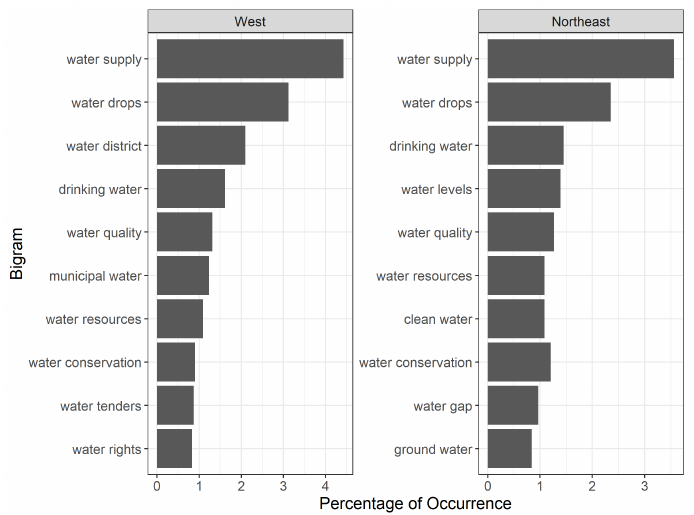
Figure A2. Bigrams of Wildfire Coverage. Issues regarding water management and districts are more prevalent in the western newspapers than the northeastern